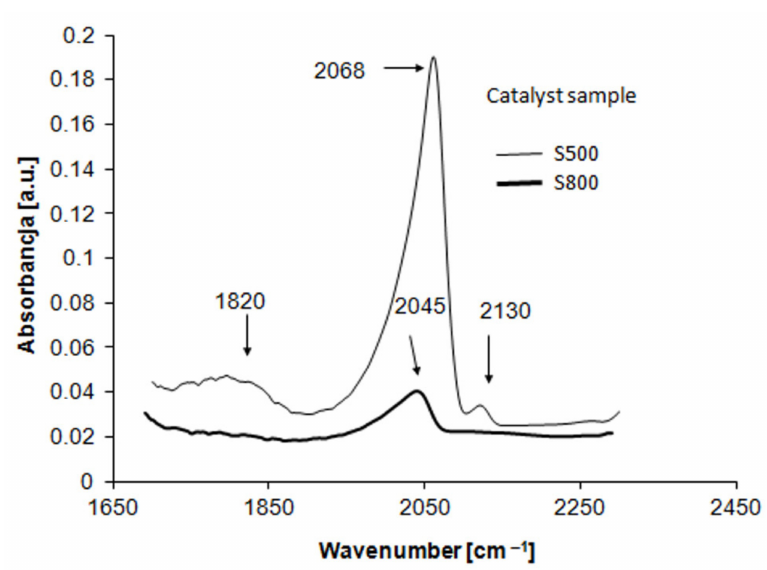
Figure 3. FTIR spectra of CO adsorption on Pt/Al 2 O 3 catalysts reduced at 500 and 800 ◦ C. For the S500 sample, both linearly [Pt-CO (2068 cm − 1 )] and bridge [Pt-(2CO) (1820 cm − 1 )]- bonded carbon monoxide was detected. In addition, a very small peak at 2130 cm − 1 was also recorded. This peak is usually assigned to CO adsorption on the oxidized form of platinum atoms [36]. Comparing the peaks areas, it can be stated that the percent concentration of the bridge-bonded CO is ca. 11%. It is worth emplacing that the difference between the D CO